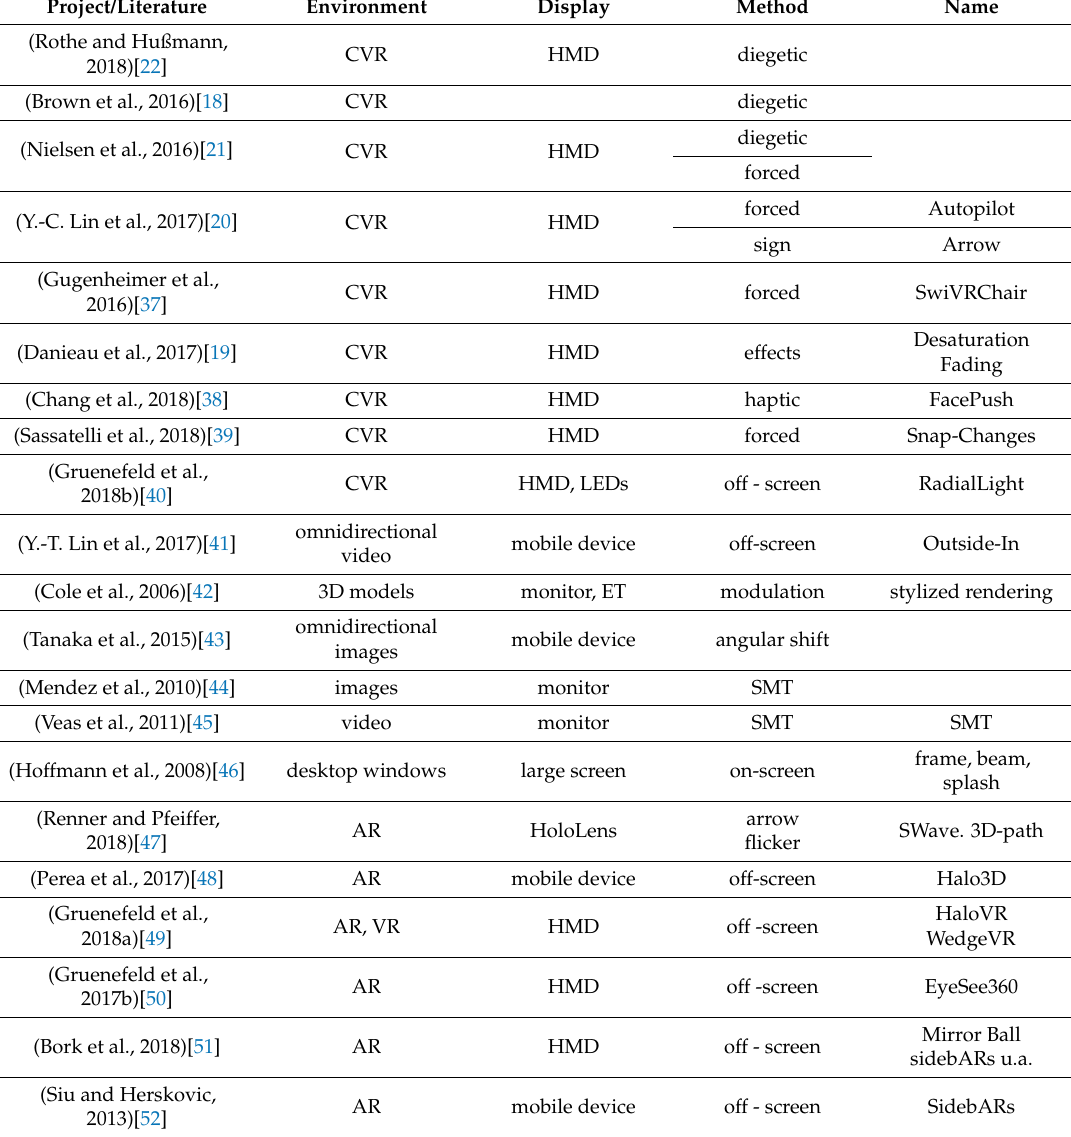
Table 2. Overview of guiding methods from research projects and the environments for which they were tested. The last column indicates the name of the method in the paper. In some of the studies, eye-tracking (ET) was used